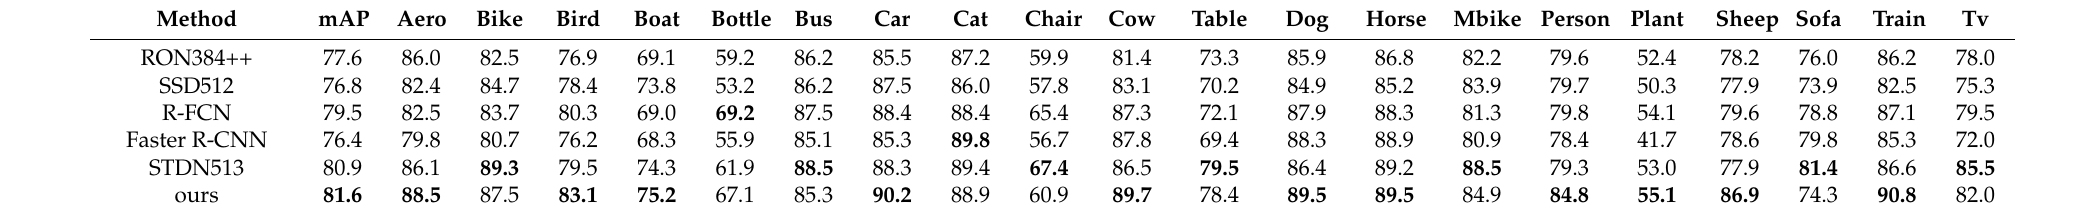
Table 6. The results of different categories on the Pascal VOC2007 test